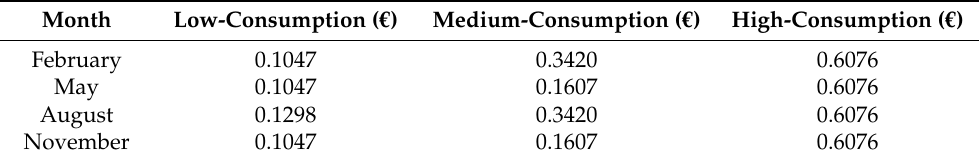
Table 1. Electricity consumption tariffs chosen according to consumption level for each season